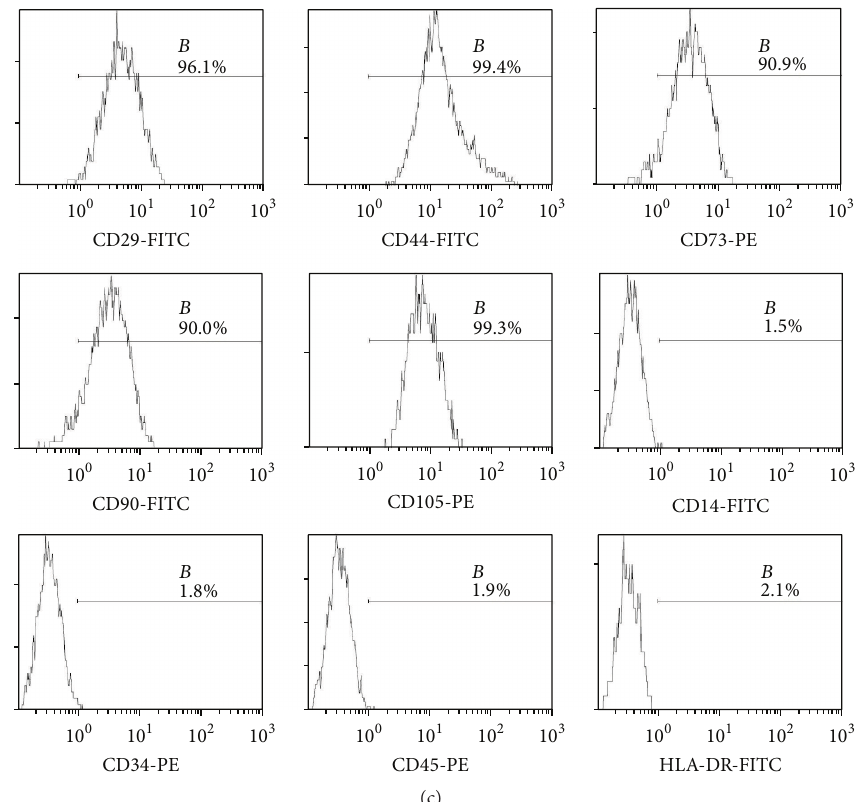
Figure 2: Phenotype identification of bone marrow mesenchymal stem cells (BMMSCs), skin mesenchymal stem cells (SMSCs), and skin fibroblasts. (a) Surface markers on BMMSCs. (b) Surface markers on SMSCs. (c) Surface markers on skin fibroblasts. The cells were